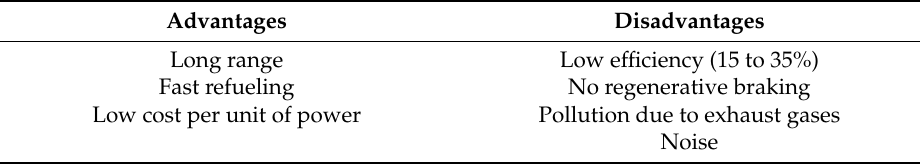
Table 1. Advantages and disadvantages of internal combustion engine vehicles